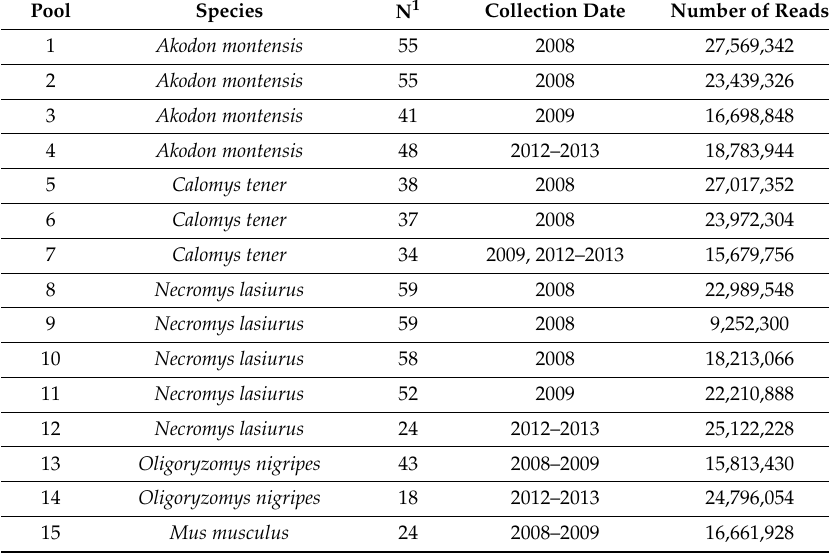
Table 1. Information of sample pools used in this